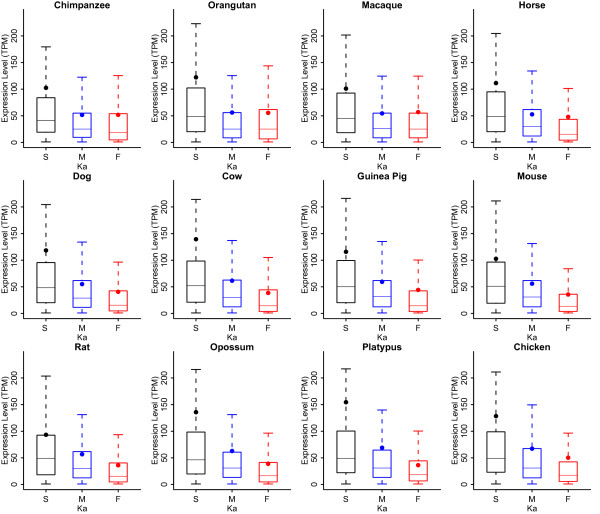
Expression level correlations and evolvability. S, M, and F stand for slow-evolving, intermediately-evolving, and fast-evolving genes, respectively. Expression levels were calibrated as the number of transcripts per million (TPM). Outliers were removed to make the plots straightforward.